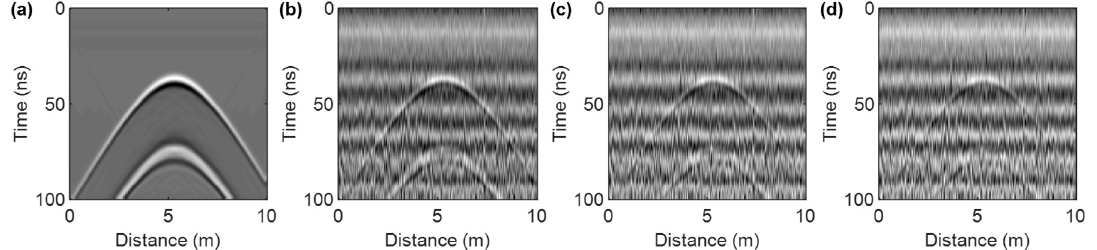
Figure 5. The comparison of radar profiles with different parameter α 1 . ( a ) The normalized radargram with α 1 = 0. ( b ) α 1 = 1. ( c ) α 1 = 1.5. ( d ) α 1 = 2.